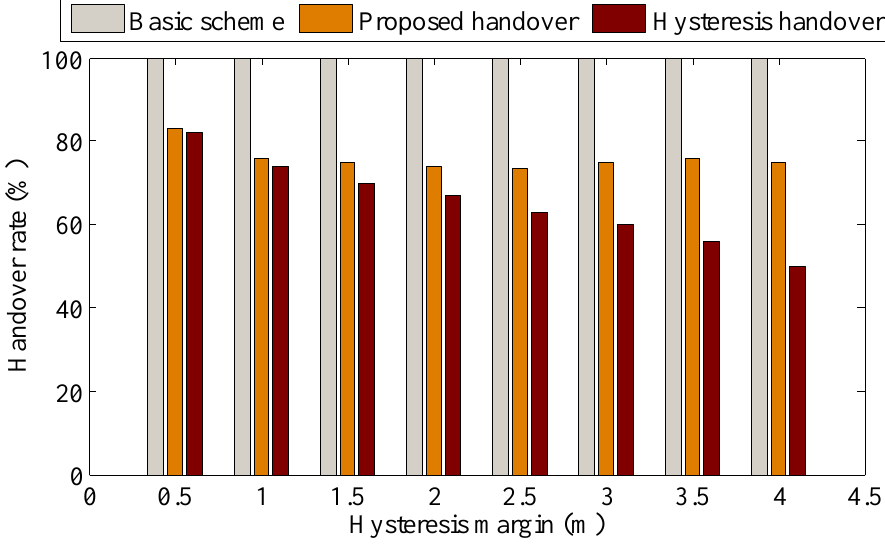
Comparison of handover rate in the BSN deployment case without constructive